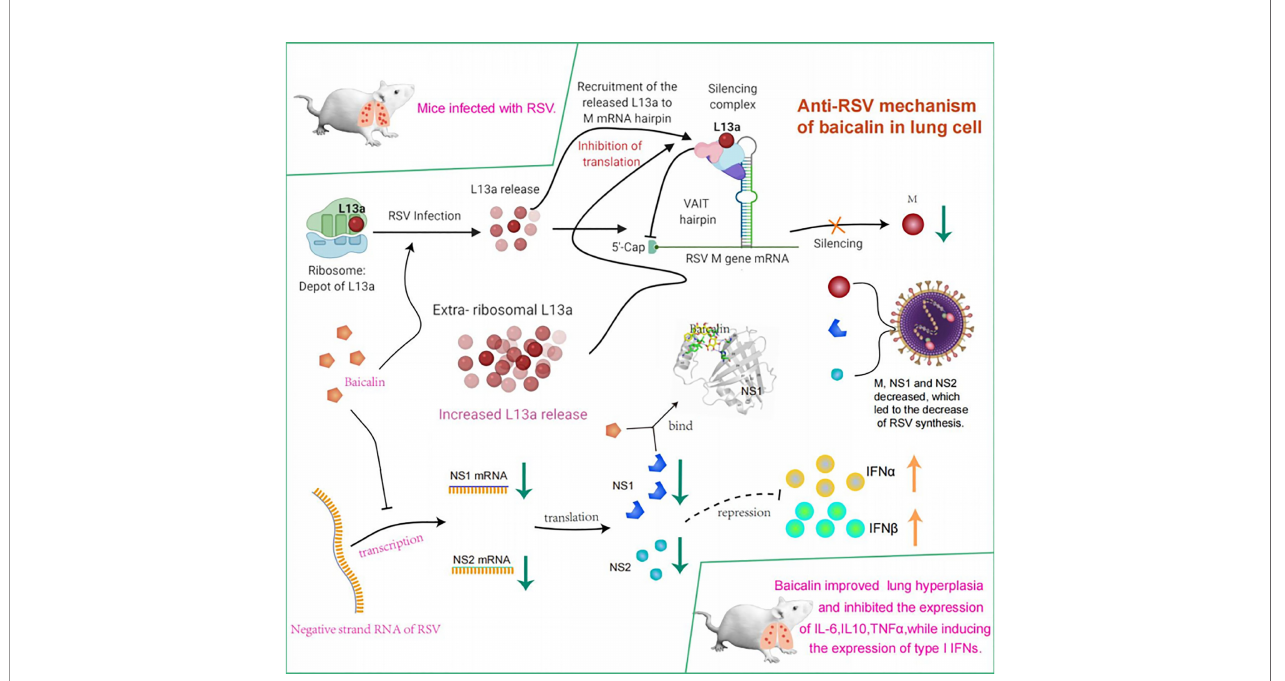
FIGURE 7 | Model summarizing mechanism underlying potent innate immune response elicited against RSV infection by treatment with baicalin. Translational regulation of RSV viral M RNA was previously elucidated (14). Brie fl y, baicalin suppresses translation of the viral M protein and transcription of the viral NS1 and NS2 proteins and downregulates the expression of pro-in fl ammatory cytokines while inducing expression of type I IFNs, thus mounting a potent anti-RSV innate immune